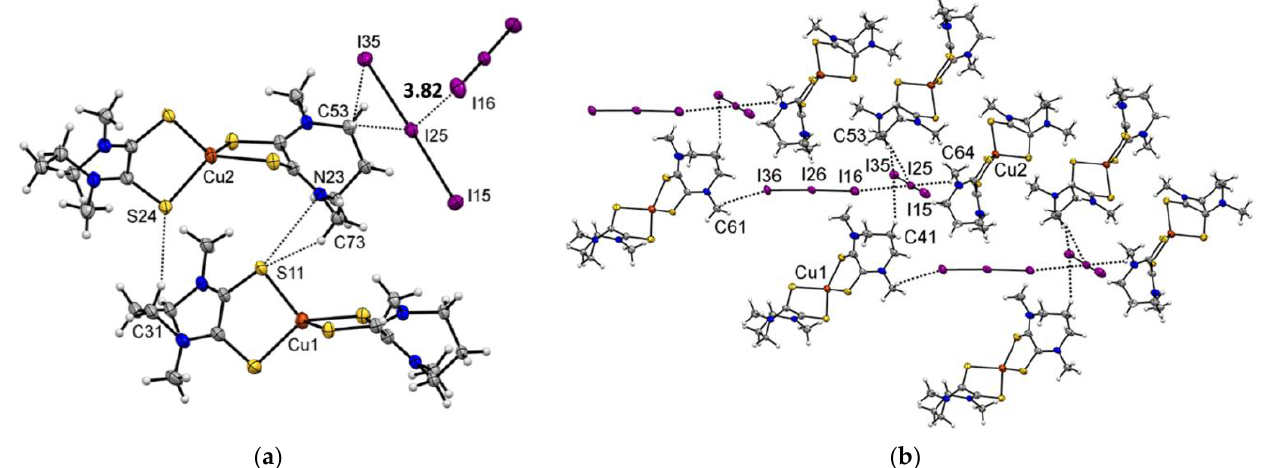
Figure 5. ( a ) Molecular structure of complex [Cu(Me 2 dazdt) 2 ]I 3 ( 5 ) with thermal ellipsoids plotted at the 50% probability level. ( b ) Portion of the crystal packing. Intermolecular interactions are depicted as dashed bonds. Halogen bond interaction is reported in Å. Table 2. Values of τ 4 and τ 4 ′ indices with coordination angles β and α (β > α).